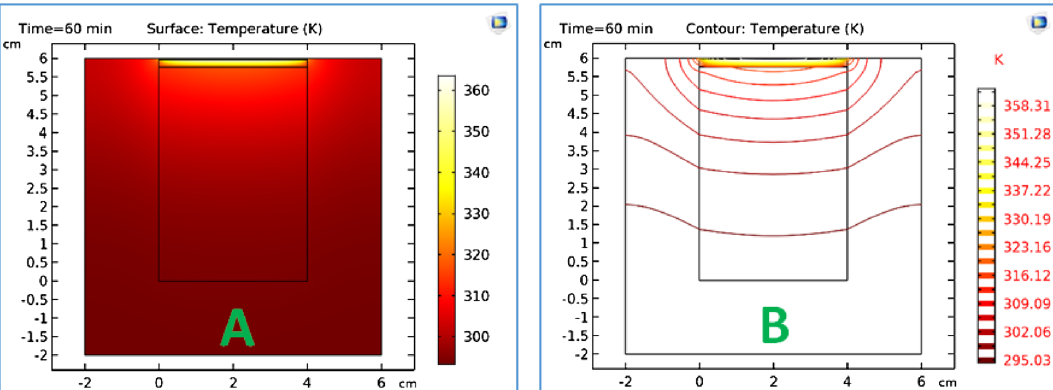
Figure 10. Schematic structure of saline water in an acrylic tank with a two-dimensional PCs of TiN coated with TiO2 with thicknesses donated by is 200 µ m and 200 µ m , respectively. The diameter of the pour equals 500 nm. The solar heat flux = 680 W/m 2 at one hour as shown, with an air gap equal to 2 mm.